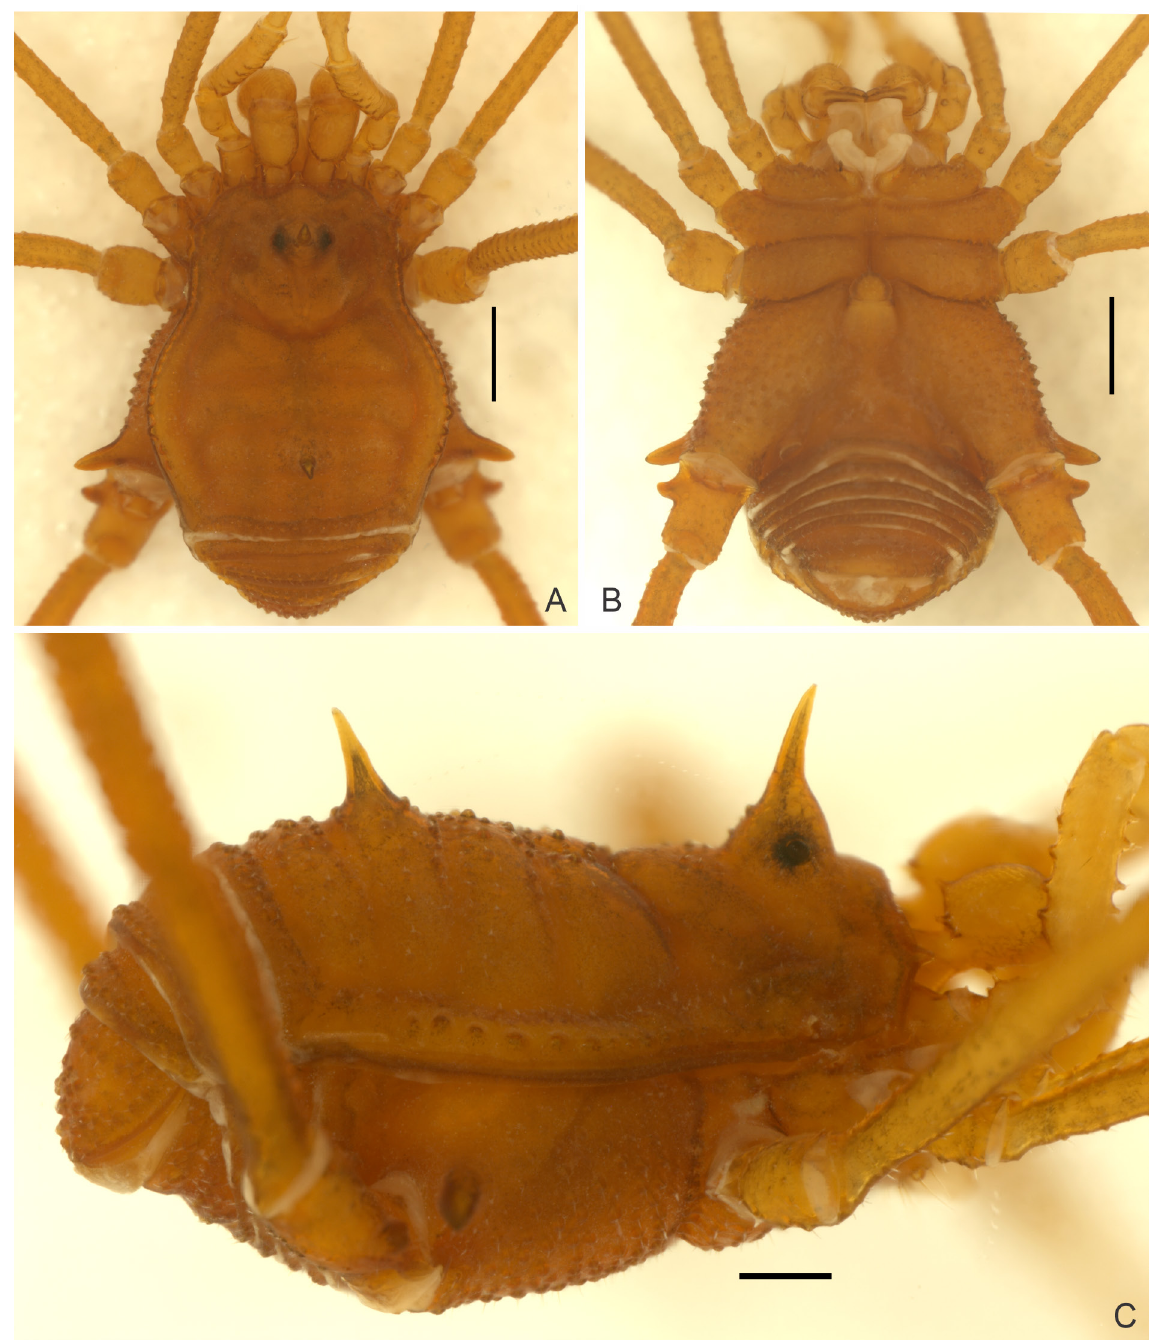
Fig. 7. Eusarcus xambioa sp. nov., ♂, holotype (ISLA 60386), habitus. A . Dorsal view. B . Ventral view. C . Lateral view. Scale bars: A–B = 1 mm; C = 0.5